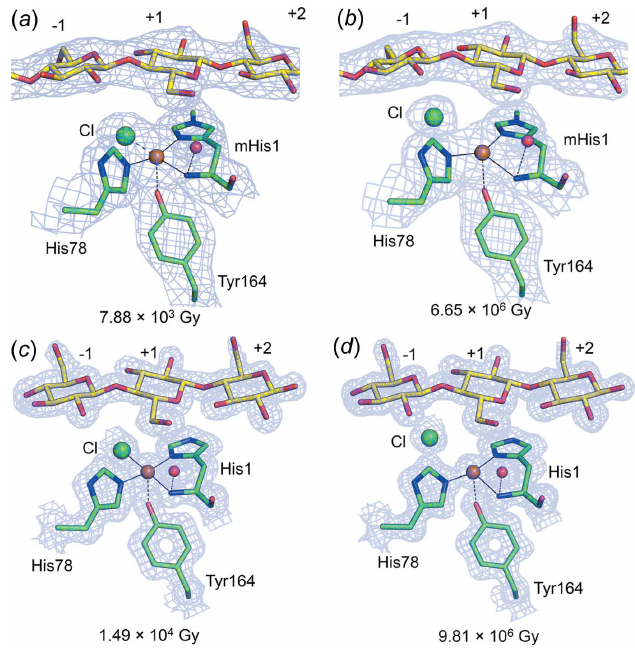
Figure 5 LPMO Cu sites in the oligosaccharide-bound structures of Ls AA9_A(f) [( a ) 7pyd and ( b ) 7pyi] and Ls AA9_A( Ec ) [( c ) 7pyu and ( d ) 7pz0] at the lowest and highest X-ray doses. For both Ls AA9_A(f) and Ls AA9_A( Ec ) at higher X-ray doses, the equatorial Cl (cid:5) ion (green spheres, present from crystallization conditions) increases its distance relative to the Cu atom. The Tyr164-O to Cu distance is, in all cases, shorter than for the substrate-free structures presented in Fig. 2. Active- site distances are listed in Table 3. 2 F o – F c electron density is shown at a 1.0 contour level as blue